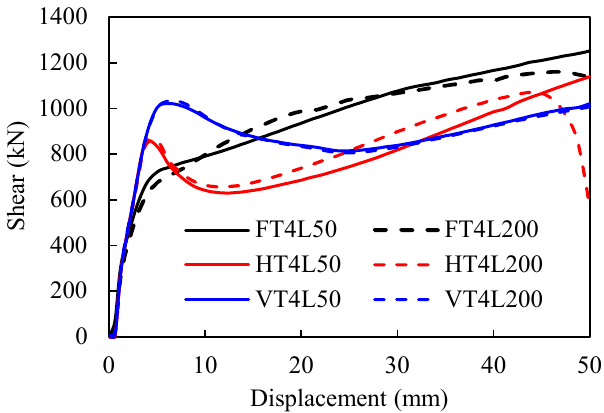
Figure 10. Shear–displacement relationship of different infill plate types. (Adapted with permission from Ref. [22]. Copyright 2022 Springer Nature.)